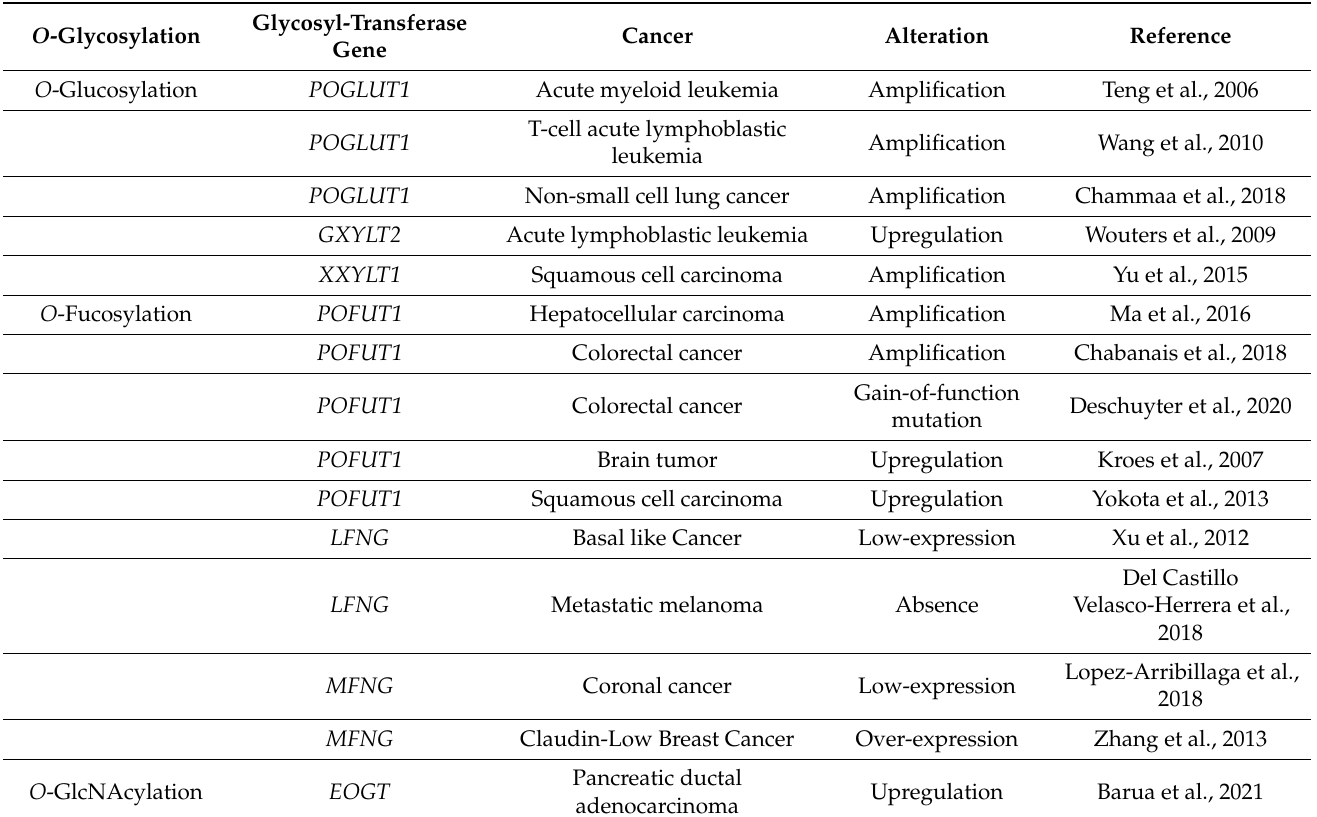
Table 1. Association between glycosyltransferase related genes and